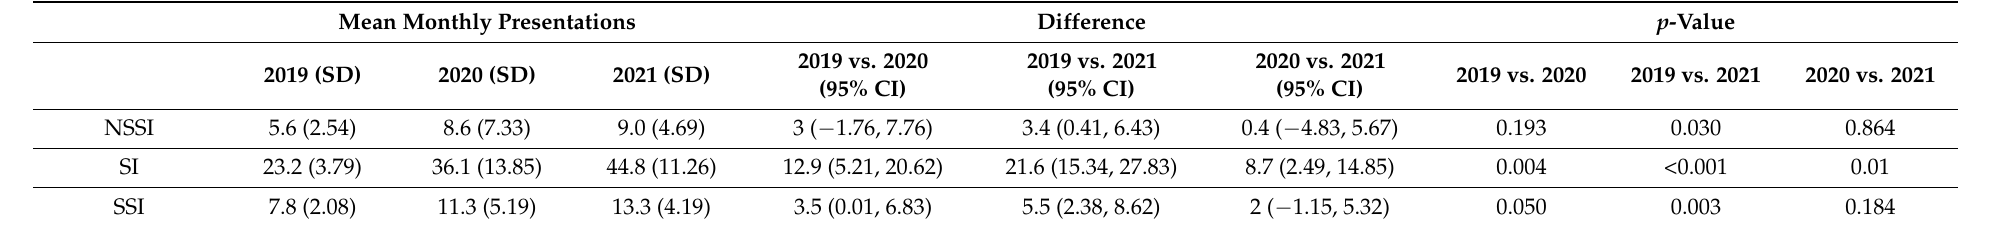
Table 3. Comparison of mean monthly presentations with non-suicidal self-injury (NSSI), suicidal ideation (SI), and suicidal self-injury (SSI). Mean Monthly